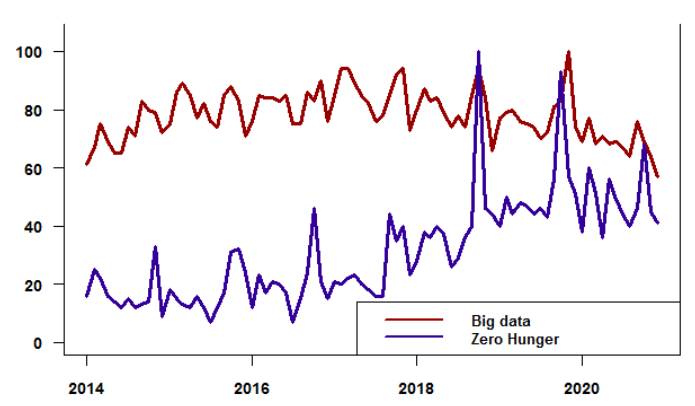
Figure 3. Big Data and SDG 2 global Google trends since